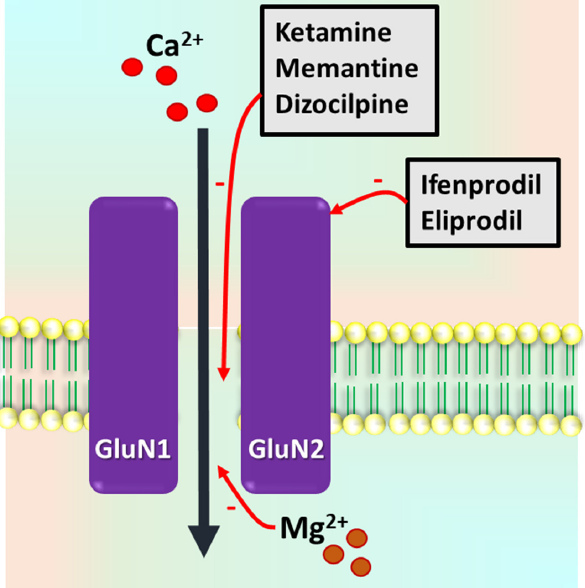
Figure 1. Schematic representation of N -methyl-D-aspartate receptor (NMDAR) complex and binding sites for GluN1 and GluN2 for some NMDAR antagonists. Ifenprodil and eliprodil mainly bind to GluN2B subunit. Mg 2+ , dizocilpine (MK-801), ketamine, and memantine act as noncompetitive antagonists with binding sites inside the ion channel pore region.